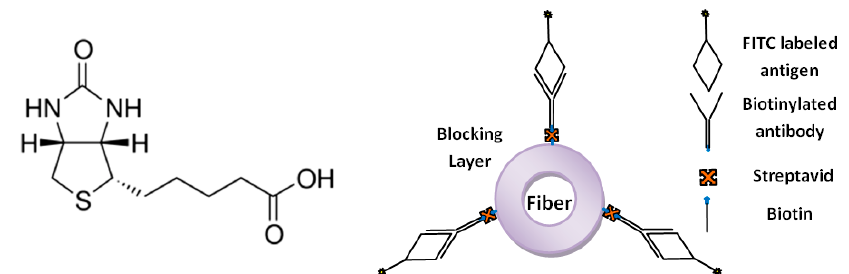
Figure 10. Chemical structure of biotin (left) and scheme of antibody/antigen immobilization on the fiber surface with the biotin/streptavidin capture mechanism (right). One active site of avidin is occupied by the biotin and the three vacant sites remain for further binding with biotinylated rabbit anti-goat IgG. The antigen–FITC is finally attached to the nanofiber surface by antibody–antigen interactions.